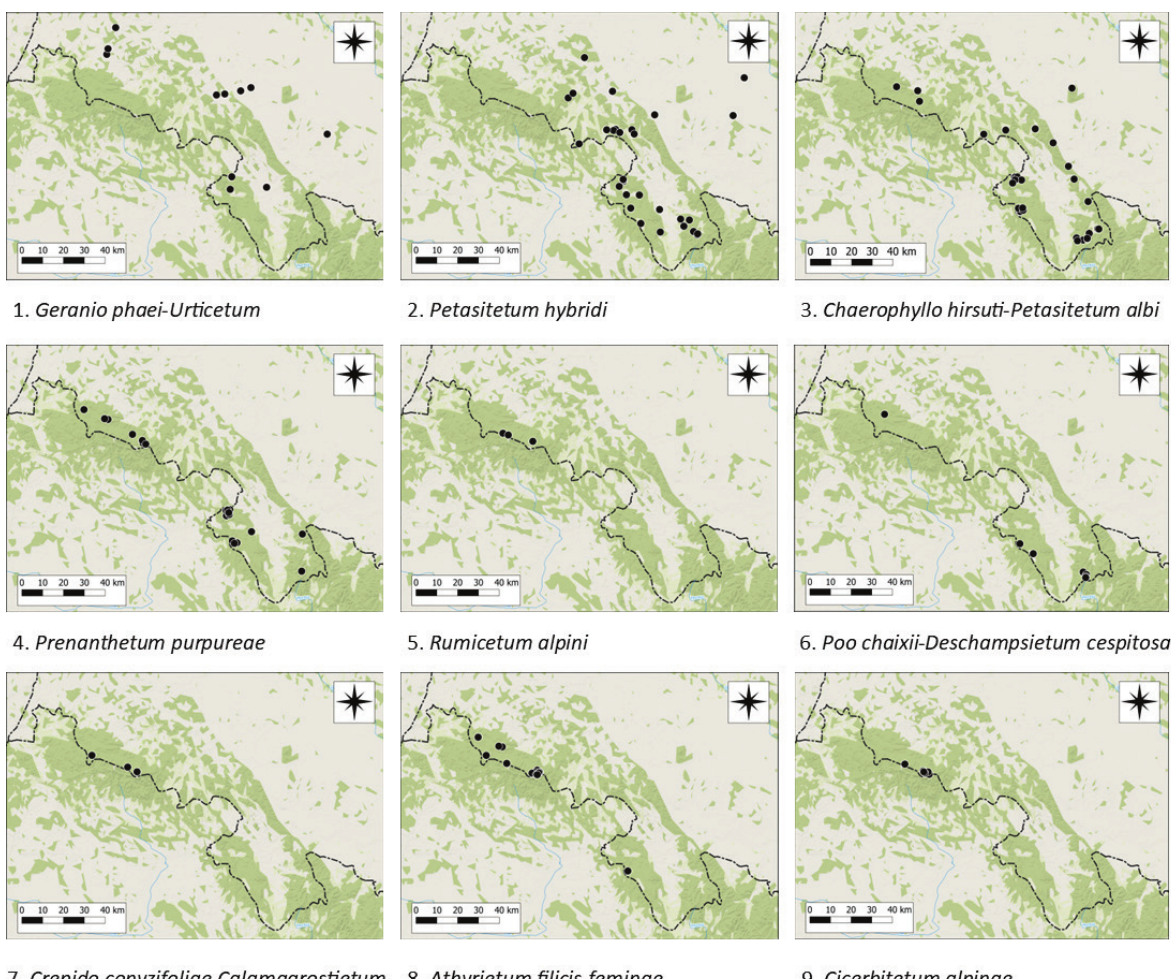
Figure 2. Distribution maps of the distinguished associations of tall-herb communities of the Sudetes Mts. and their foothills. The numbers refer to the group IDs used throughout this paper. Background from © MapTiler © Open- StreetMap